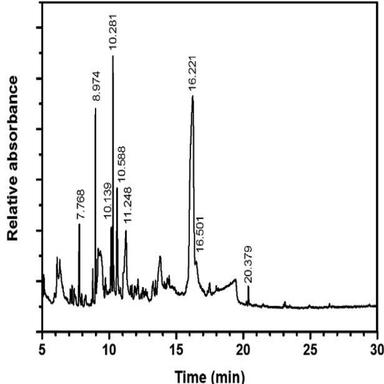
GC-MS chromatogram for the water soluble fractions of Lonicera japonica flower.